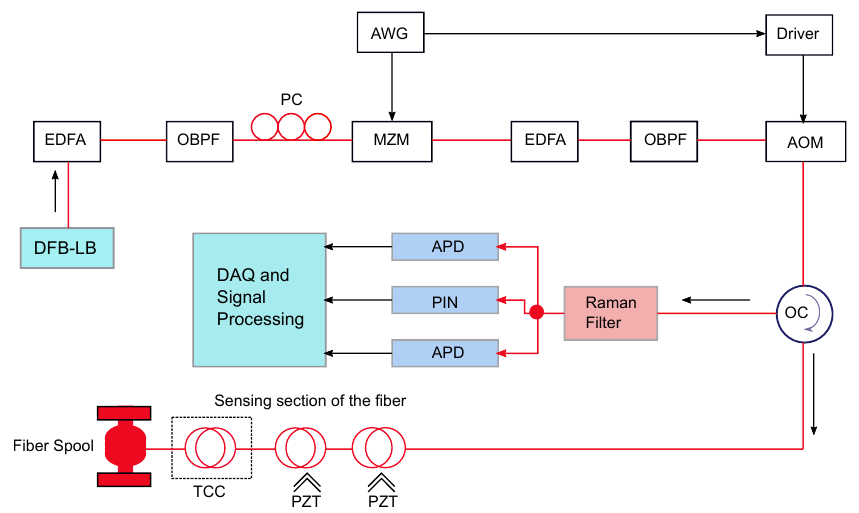
Figure 10. Experimental setup of the hybrid Raman-DTS and φ -OTDR system for simultaneous measurements of vibration and temperature. DFB-LD: Distributed Feedback-Laser Diode, EDFA: Erbium Doped Fiber Amplifier, OBPF: Optical Bandpass Filter, MZM: Mach–Zehnder